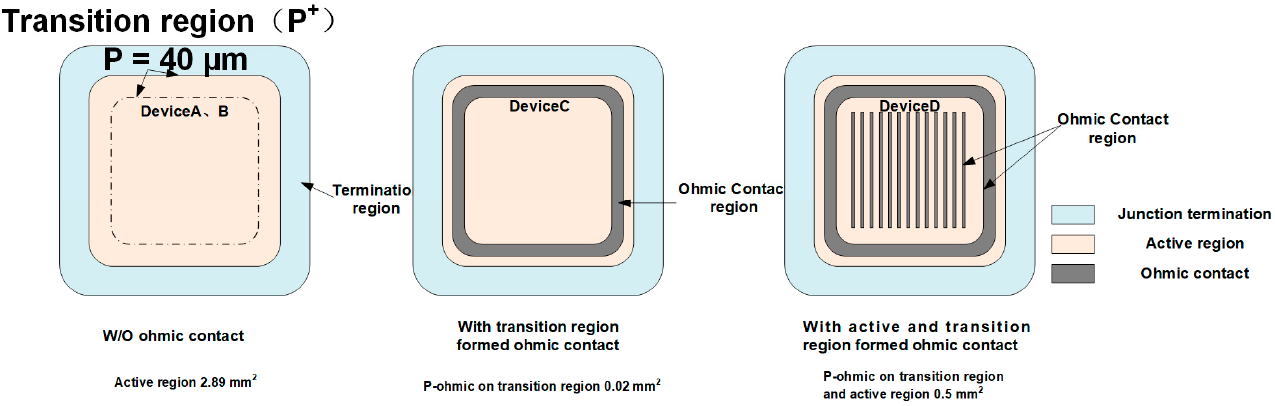
Materials 2021 , 14 , x FOR PEER REVIEW 5 of 14 Figure 4. Junction barrier Schottky diode (JBS) and merged PiN Schottky diode (MPS) process flow.